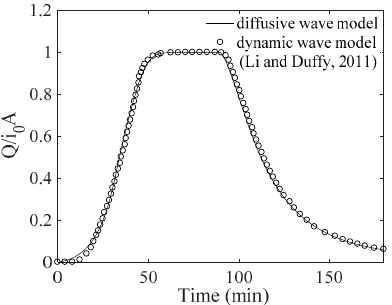
Figure 4. Computed discharges at the basin outlet.